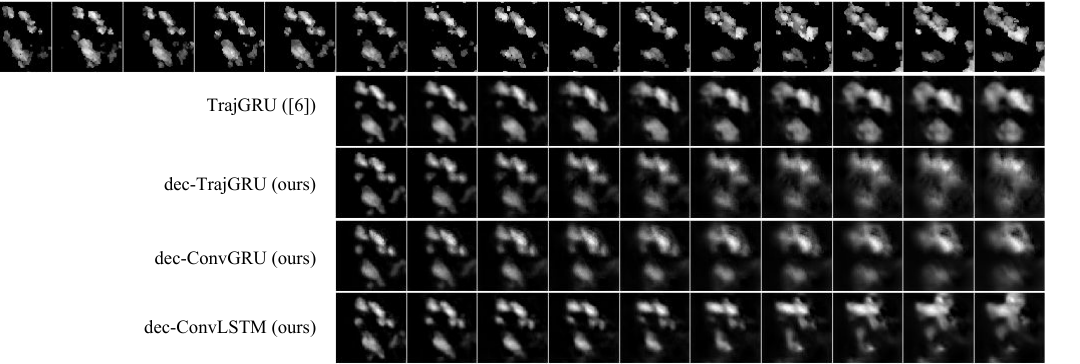
Figure 7. Example of predicted results of three dec-seq2seq models. The result of TrajGRU from Section 4.1 is copied here for convenient